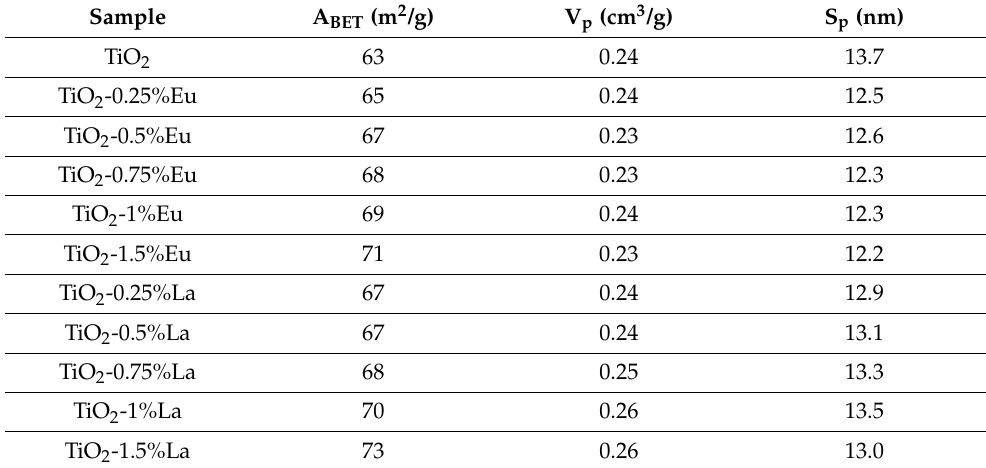
Table 4. The parameters of the porous structure for TiO 2 -Eu and TiO 2 -La systems. Sample